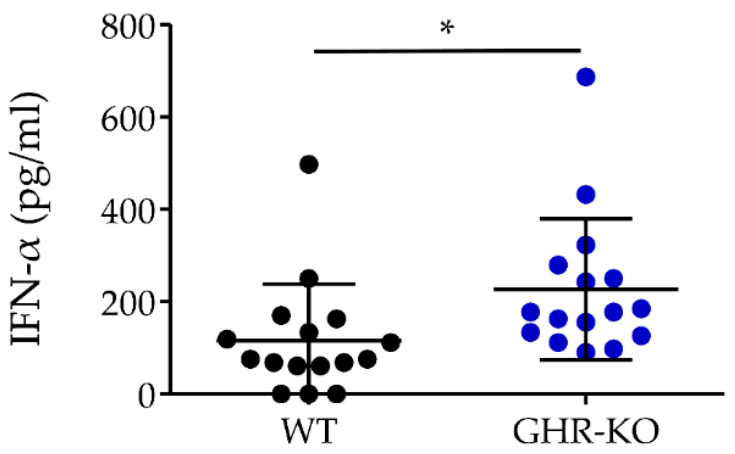
Figure 7. Interferon- α (IFN- α ) concentration in pg/mL in sera from WT (black dots, n = 16) and GHR-KO pigs (blue dots, n = 16). GHR -KO pigs had significantly higher serum concentrations of IFN- α . Data are expressed as mean ± SD (* = p ≤ 0.05).